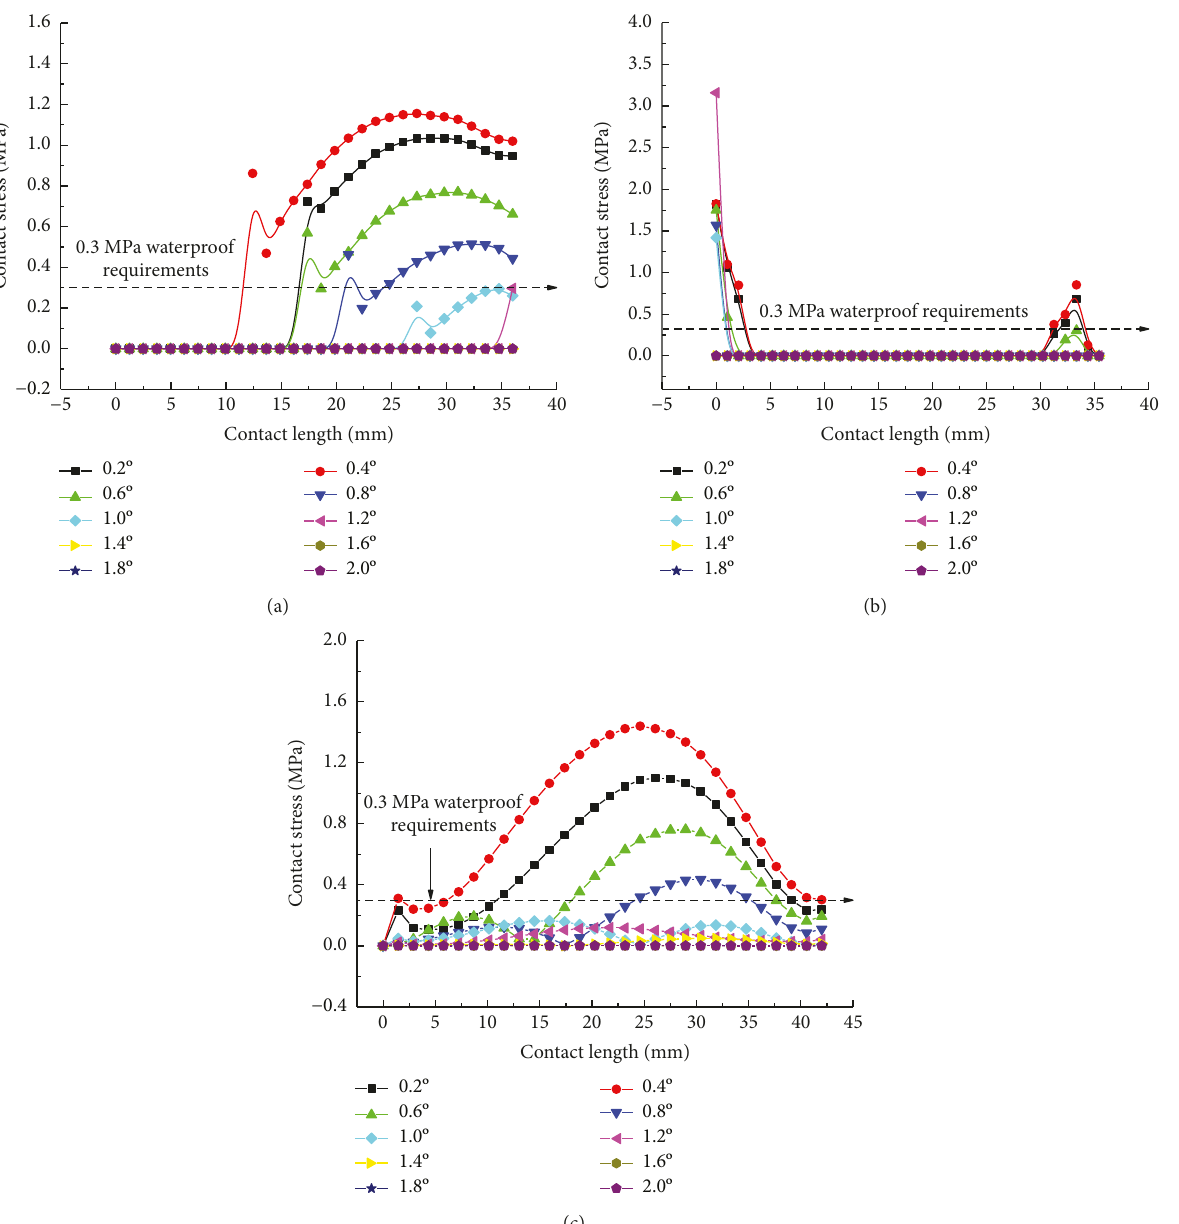
Figure 16: Contact stress curve of the first rubber ring before optimizing during clockwise rotation: (a) contact pressure of line 1 for the first rubber ring, (b) contact pressure of line 2 for the first rubber ring, and (c) contact pressure of line 3 for the first rubber